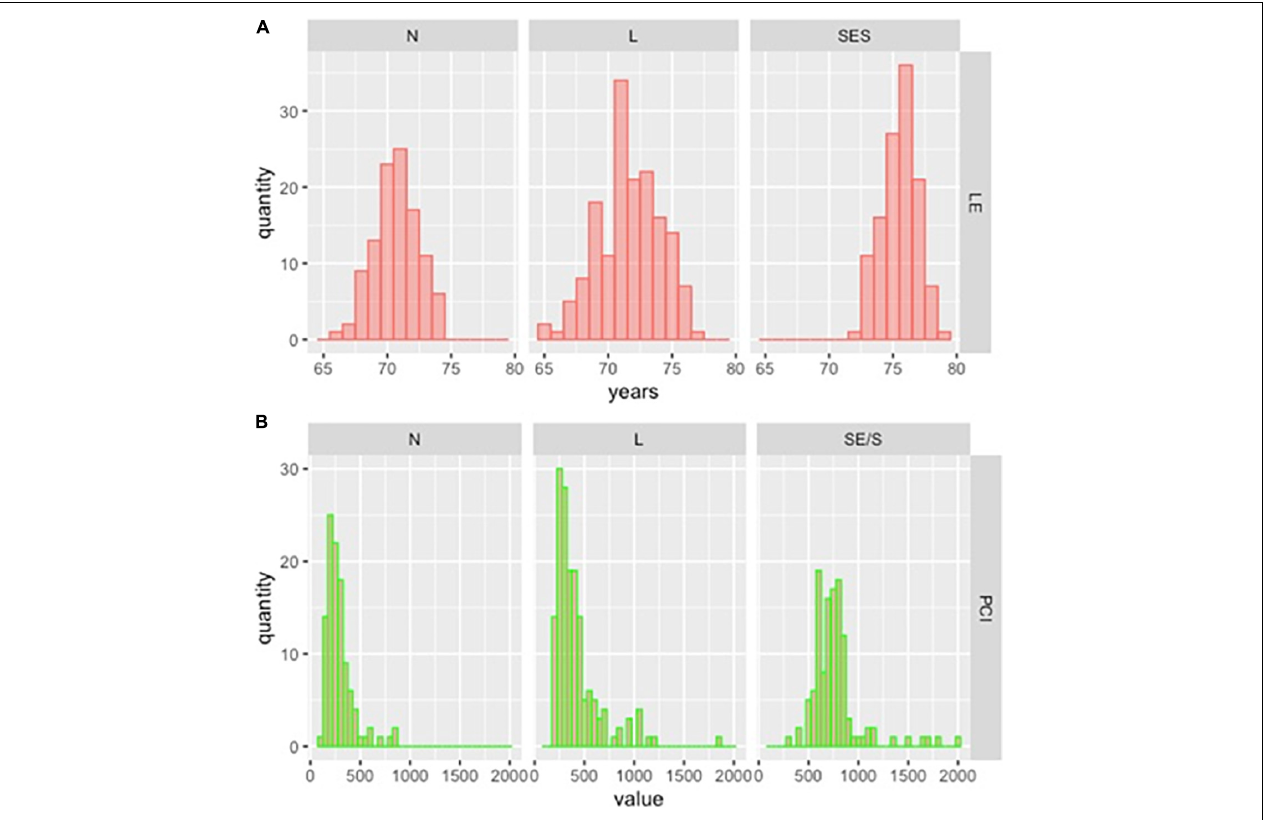
FIGURE 6 | Histogram of the municipal distribution based on the HDMI indicators of (A) life expectancy at birth and (B) per capita income. Elaborated by the authors with data from PNUD et al. (2020).